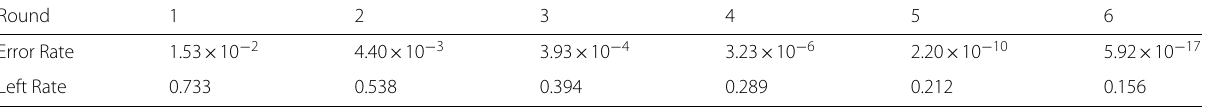
Table 3 The upper bound of error rate based on Lemma 1 and the left bit rate after each error correction round Round 1 2 3 4 Error Rate Left